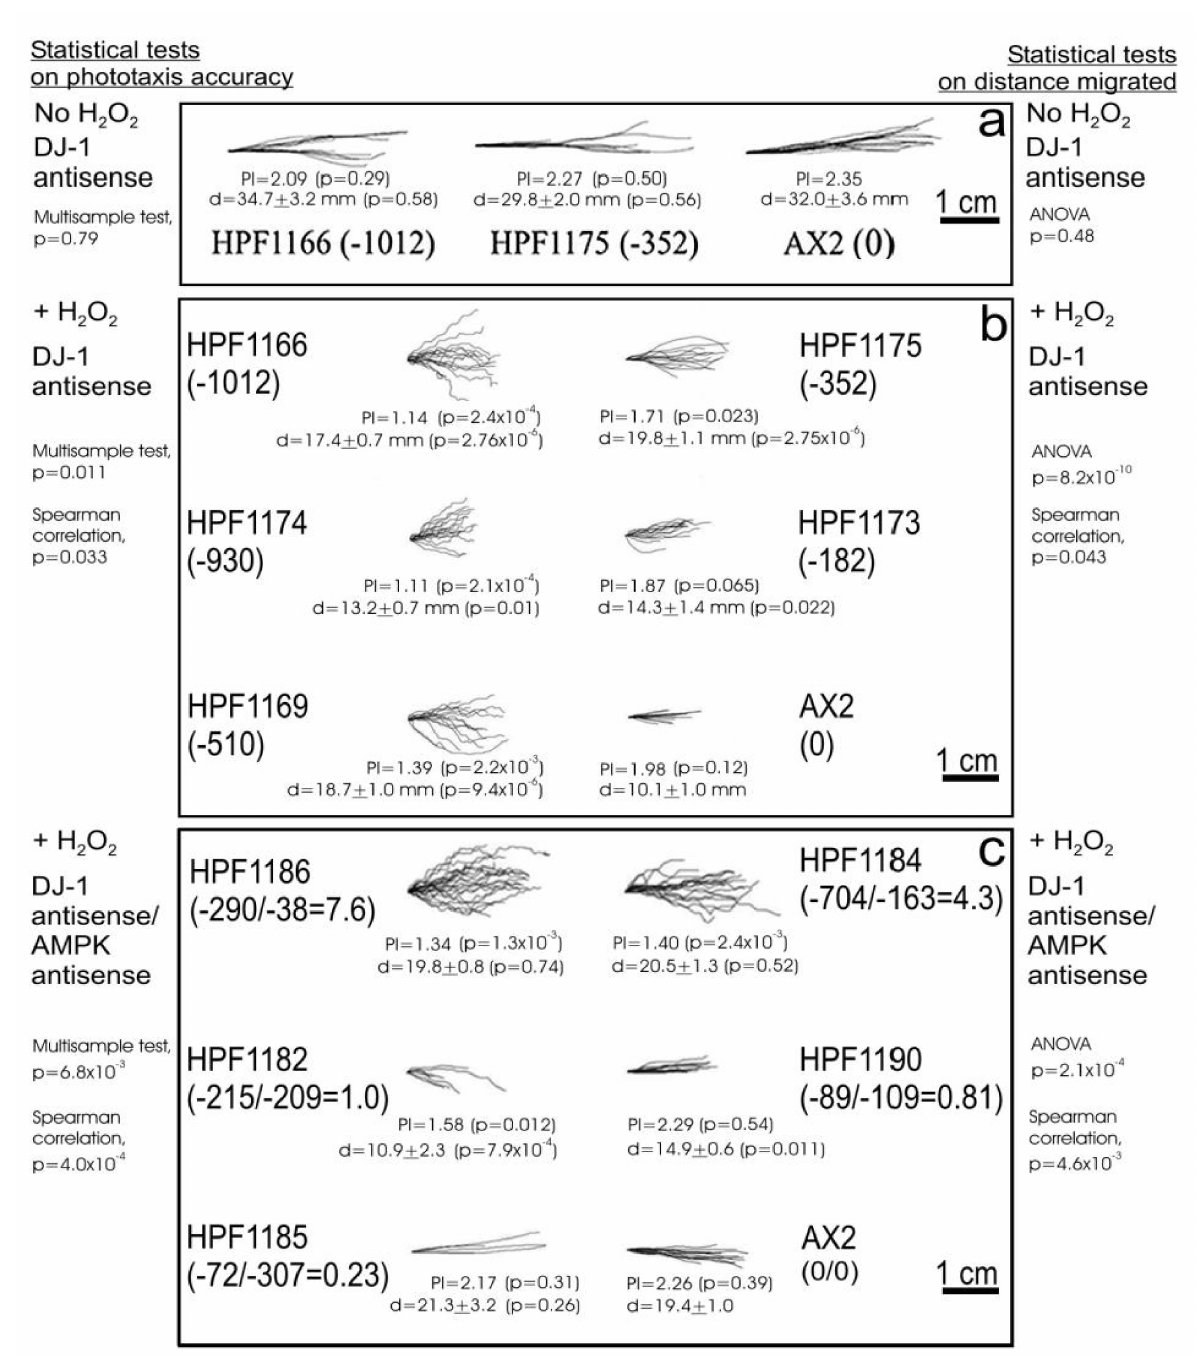
Figure 3. Phototaxis under oxidative stress by slugs of DJ-1 antisense transformants and DJ-1/AMPK double antisense cotransformants of the parental strain AX2. Slugs were formed from 2.5 × 10 6 amoebae inoculated onto a 1 cm 2 area in the center of each plate containing water agar supplemented with 900 µ M H 2 O 2 and allowed to migrate for 2 days with a lateral light source at 21 ◦ C. The directions of travel were analyzed using directional statistics based on the von Mises circular normal distribution. PI, the phototaxis index, is the log of κ , the concentration parameter of the von Mises distribution (equivalent to the inverse of the variance of the directions). The mean distance migrated with standard errors is indicated for each set of trails. Two-sample and multisample tests of differences in phototactic accuracy were as described previously [37]. Two-sample and multisample tests of differences in the mean distance migrated used the t -test and ANOVA, respectively. H 2 O 2 had no significant effect on the accuracy of phototaxis by the wild type parental strain ( p = 0.46), but did significantly reduce the distance migrated (ANOVA, p = 2.0 × 10 − 6 ). ( a ): Digitized trails of DJ-1 antisense and parental (AX2)